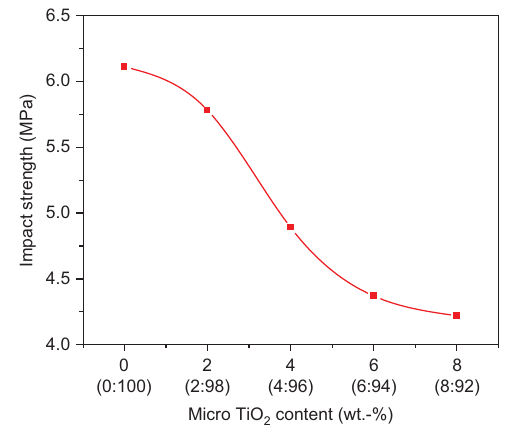
Figure 8 Impact strength of micro-TiO